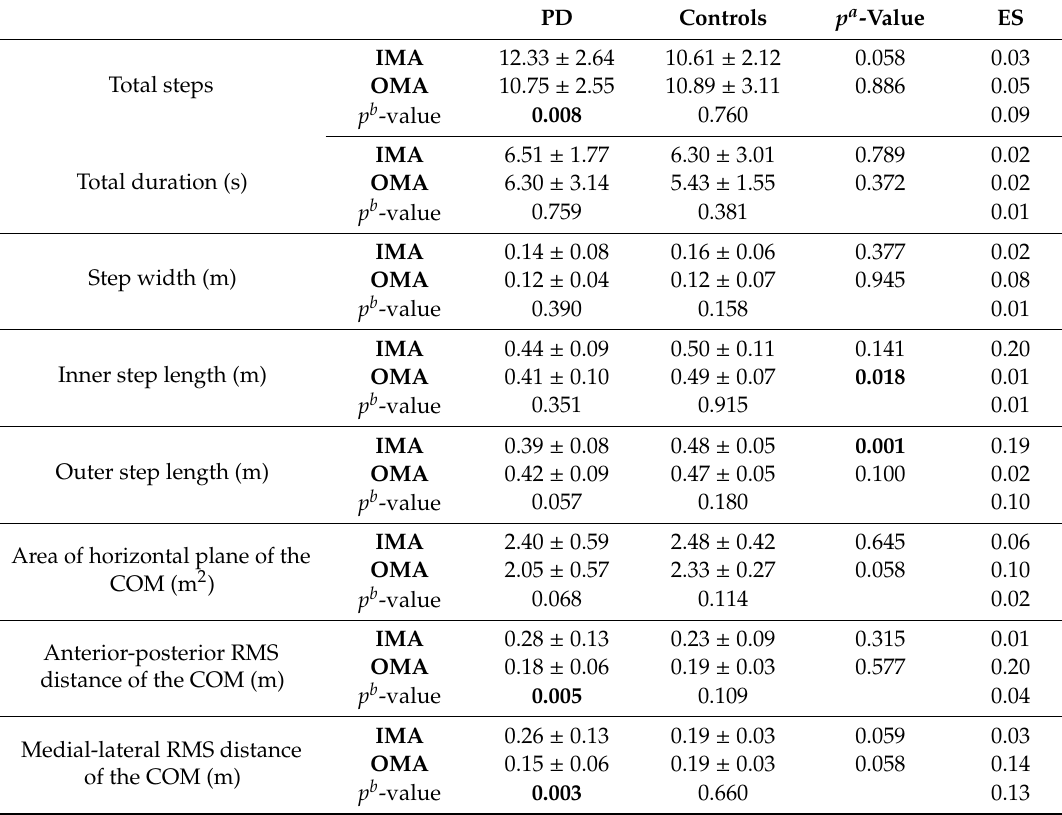
Table 3. Comparison of turning characteristics of PD patients and controls for the 540 ◦ turning task at maximum